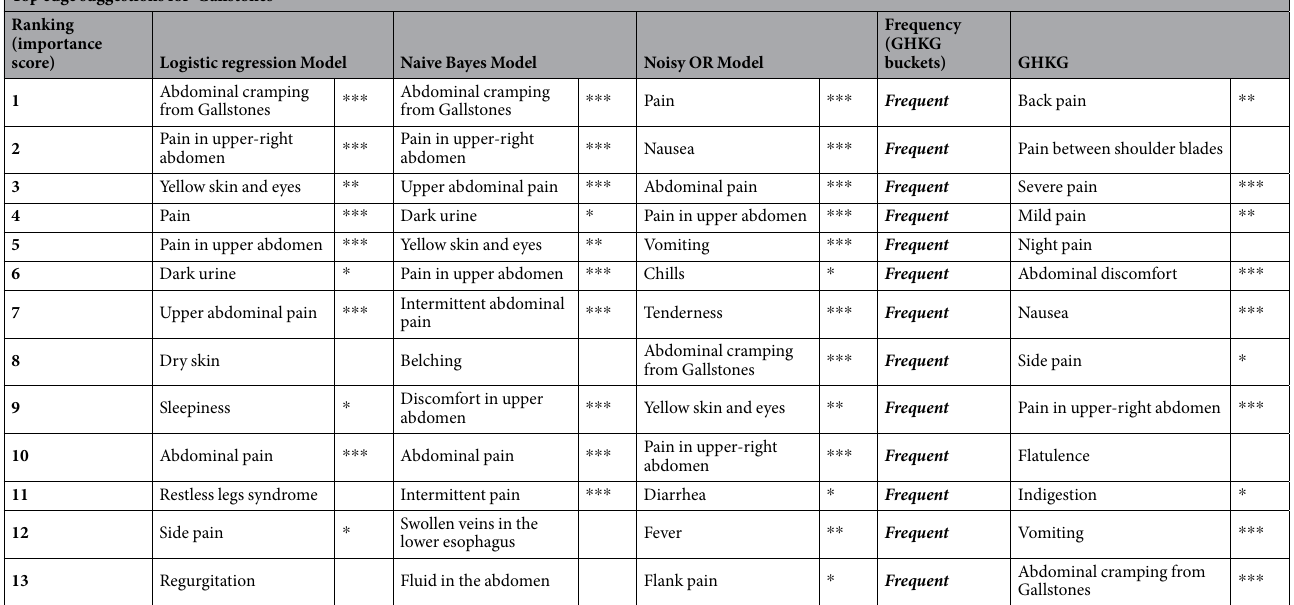
correlation and causation is partly avoided using the noisy OR model. We give a formal explanation for this in the appendix. We note that this is particularly relevant since many patients have multiple diseases (Fig. 3). Limitations. Our evaluation focused on the ability of the proposed algorithms to recover known causal rela- tions involving diseases and symptoms. However, any approach that seeks to infer causal relations from observa- tional data, as we do, inherently has major limitations. For example, unobserved confounding factors will affect the ability of all of the proposed approaches to infer correct causal relations 38, 39 , and proving causality would require many additional experiments. Rather, our algorithms should be construed as only providing candidate causal relations.